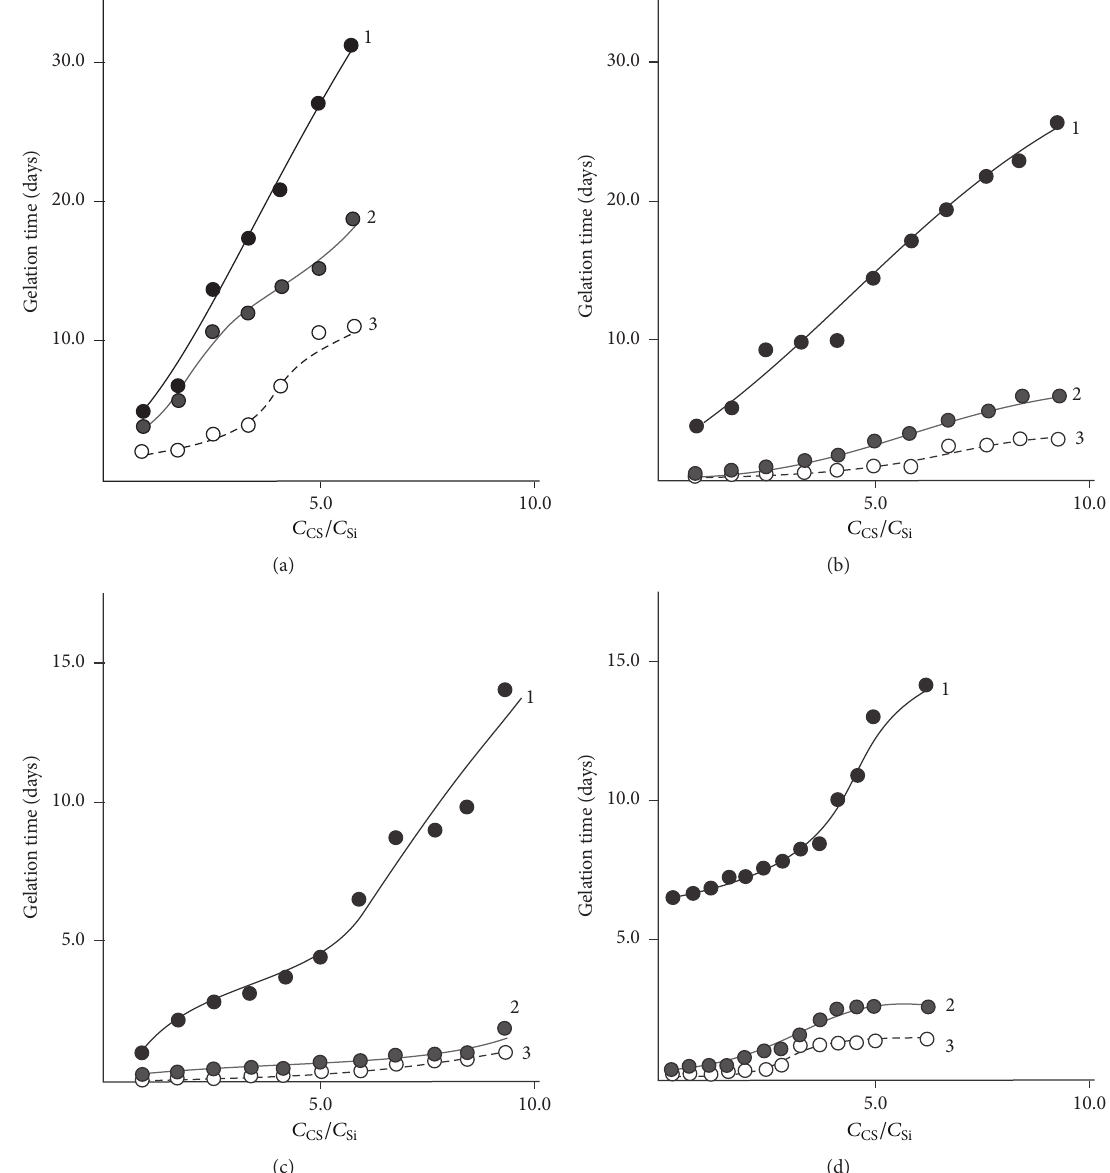
Figure 1: Dependence of the gelation time for systems CS-GA + Si(OGly) 4 ⋅ 2GlyOH on 𝐶 CS /𝐶 Si at aX = 2.27 ± 0.13 (a), 3.81 ± 0.04 (b), 4.26 ± 0.05 ( c ), and 5.33 ± 0.08 (d), on the incubation temperatures 4 (1), 20 (2), and 37 ∘ b (3) without (a, b, and d) and with addition of 1wt.% NaCl